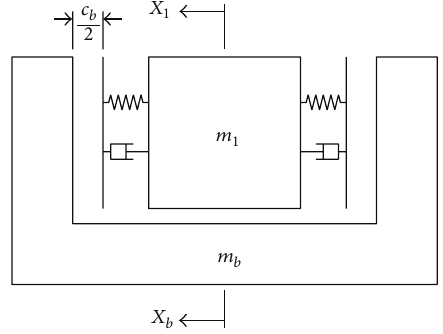
Figure 11: Modeling of the U-type guide with backlash.